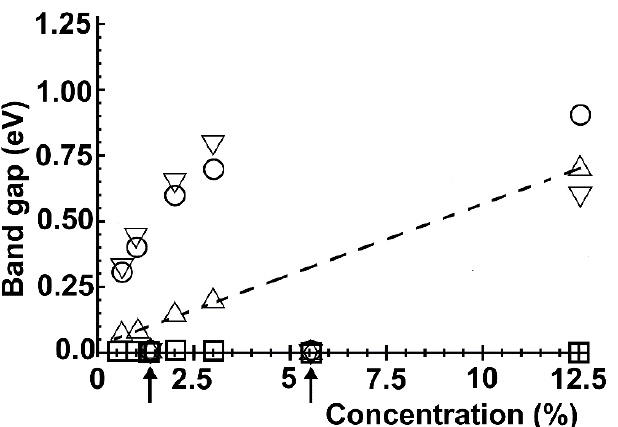
Figure 13. We show the bandgap variation around the Fermi energy for different dopant (vacancy) percentage densities. The arrows indicate the unit cell sizes that follow the 3N rule [23] (1.39% and 5.55%). Nitrogen: (cid:52) ; oxygen: O; Fluorine: (cid:53) ; vacancy: (cid:3) . In the case of nitrogen, there is a linear behavior.